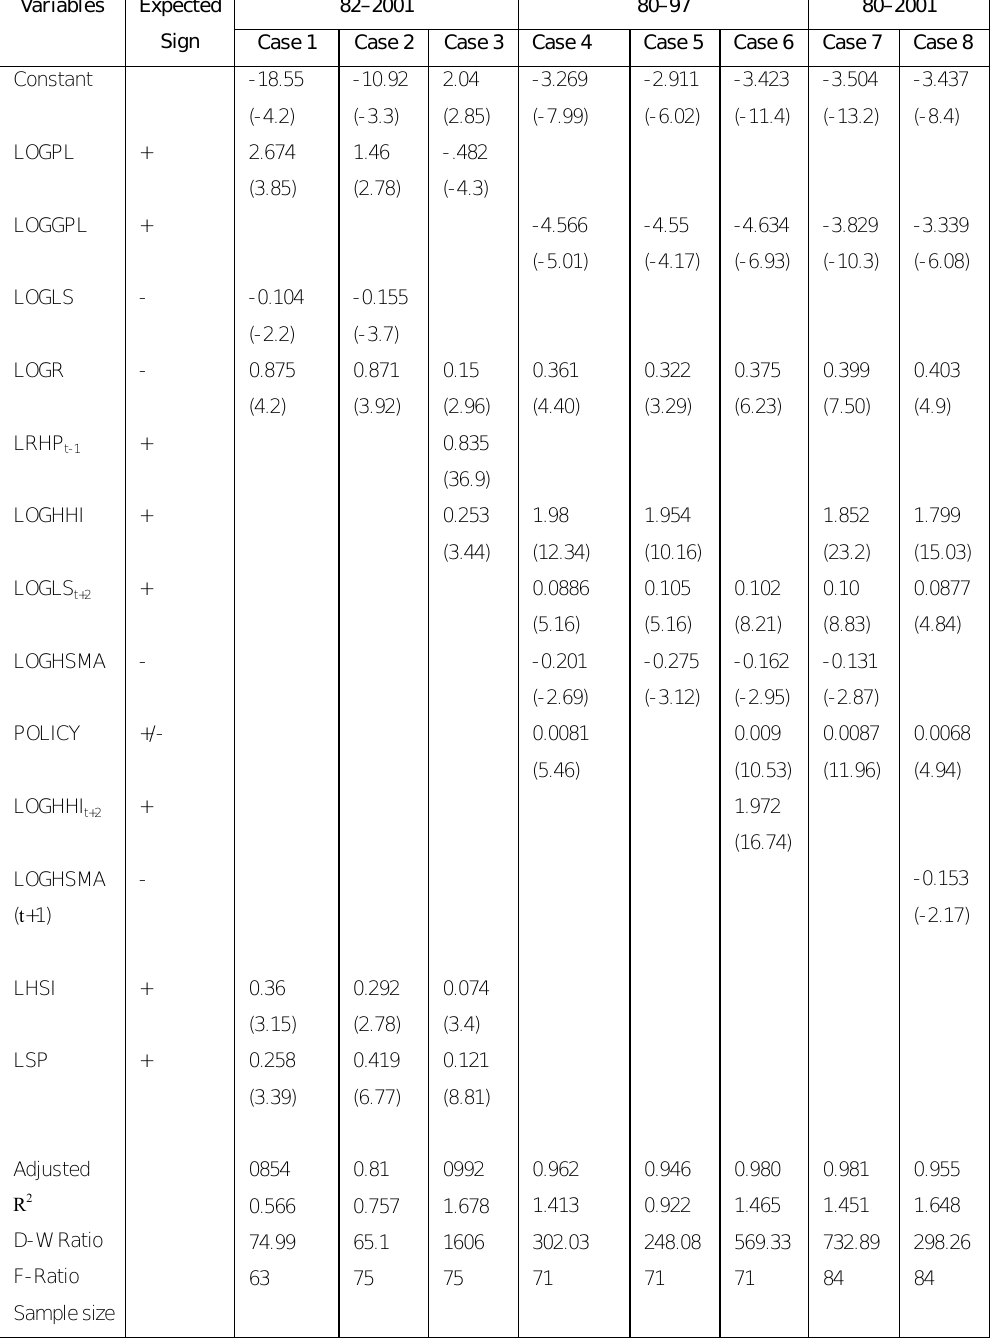
Table 6: Regression Results with Dependent Variable =